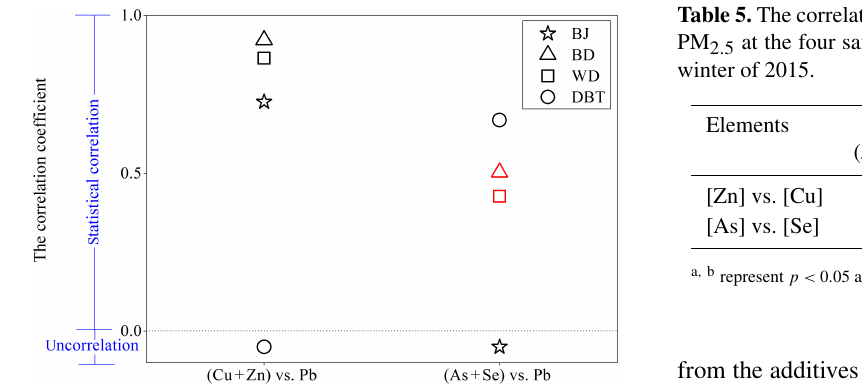
Figure 10. The statistical correlations for [ Cu + Zn ] vs. [Pb] and [ As + Se ] vs. [Pb] in PM 2 . 5 at the four sampling sites during the sampling period in the winter of 2015. The uncorrelated results are also marked below zero on the y axis. The red and black symbols represent p < 0 . 05 and p < 0 . 01.